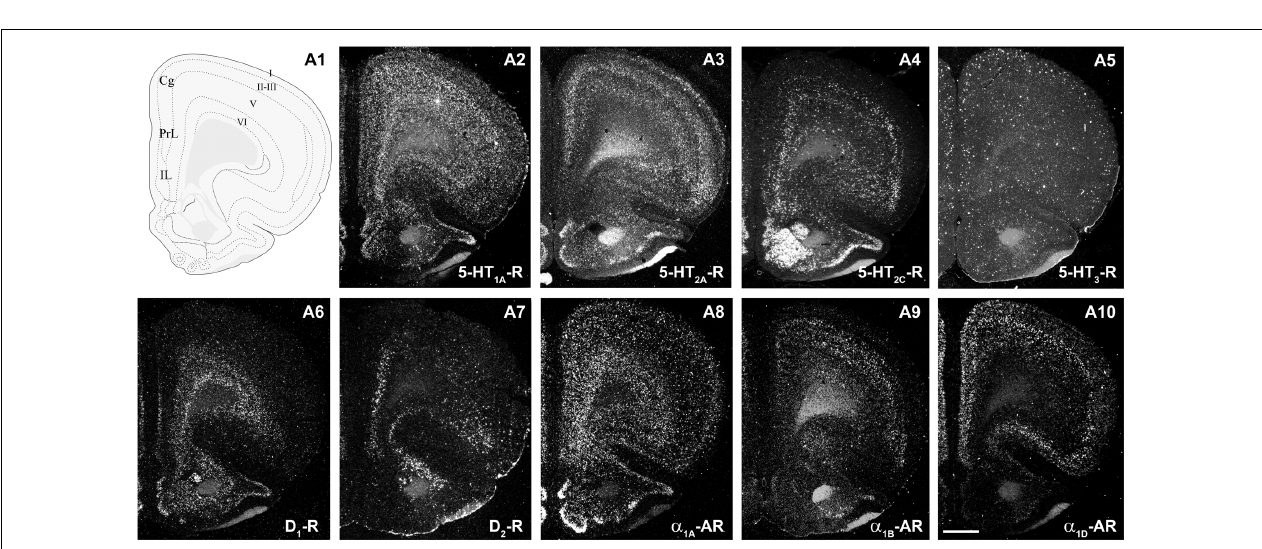
FIGURE 2 | mRNA expression of monoaminergic receptors in rat prefrontal cortex (PFC). (A1) Coronal diagram from the rat brain atlas Swanson (2004) (used under CC BY-NC 4.0) at the approximate AP coordinate where cell counts have been performed in the cingulate (Cg), prelimbic (PrL), and infralimbic (IL) subdivisions. (A2–A10) Emulsion dipped dark-field PFC coronal sections hybridized with 33 P-labeled oligonucleotide probes against the mRNAs encoding 5-HT 1A -R (A2) , 5-HT 2A -R (A3) , 5-HT 2C -R (A4) , 5-HT 3 -R (A5) dopamine D 1 -R (A6) , dopamine D 2 -R (A7) and α 1A -, α 1B - and α 1D -adrenoceptors ( A8–A10 , respectively). Bar: 1 mm. See Puig et al. (2004), Santana et al. (2004, 2009, 2013), Santana and Artigas (2017) for detailed